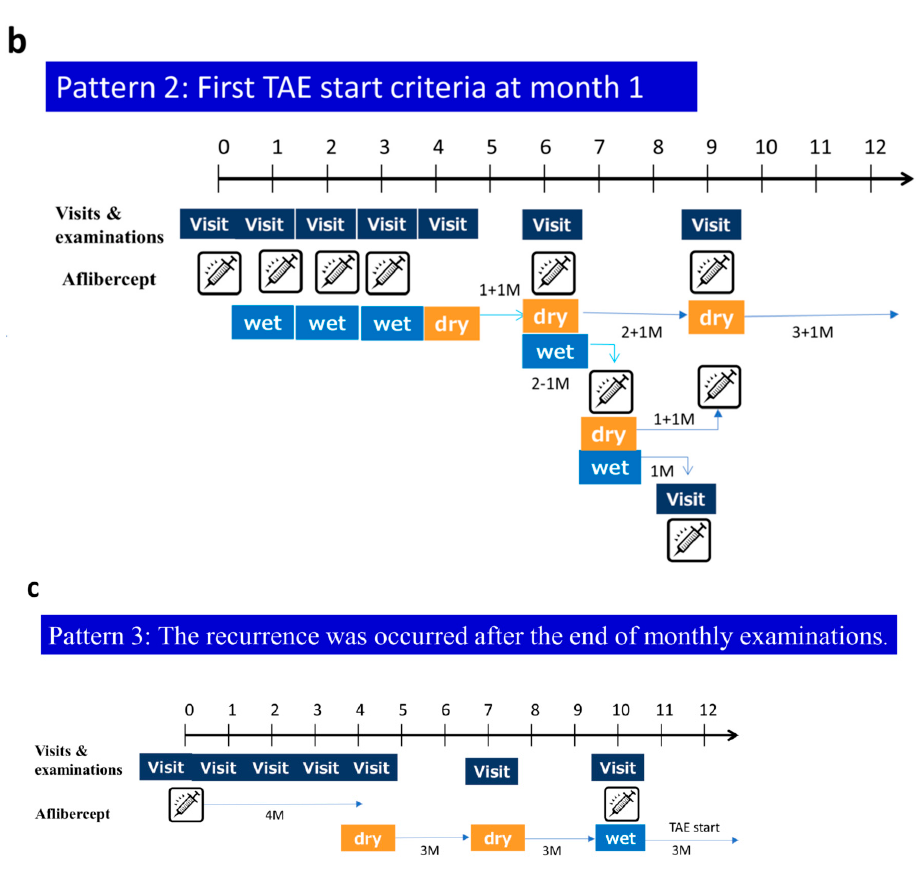
Figure 1. Example of the administration method for the modified treat-and-extend (mTAE) regimen. ( a ) This pattern shows the first retreat criteria met at month 3. ( b ) This pattern shows the first treat-and-extend (TAE) start criteria met at month 1. ( c ) This pattern shows the recurrence that occurred after the end of the monthly examinations.